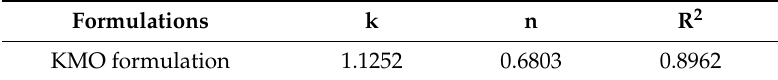
Table 8. Flow behavior indices (n), consistency coe ffi cients (k), and regression coe ffi cients (R 2 ) of the KMO formulation in TFS.